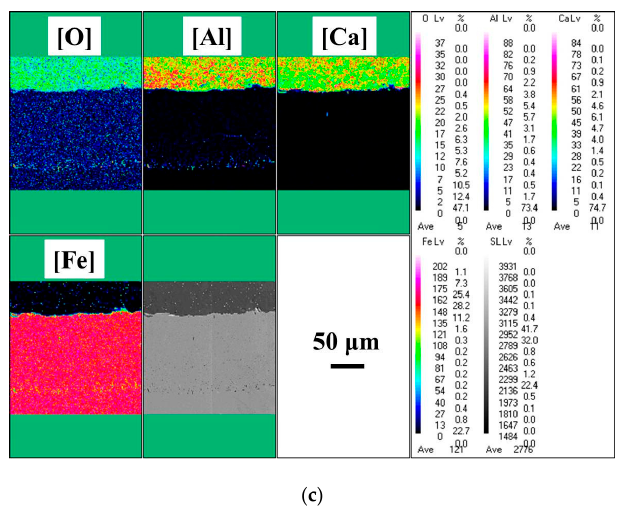
Figure 7. SEM images and measured distributions of O, Fe, Al, and Ca at the vicinity of the interface between the alloy and oxide in the diffusion couple of G0-50, G1-50, and G2-50: ( a ) G0-50; ( b ) G1-50; ( c ) G2-50.